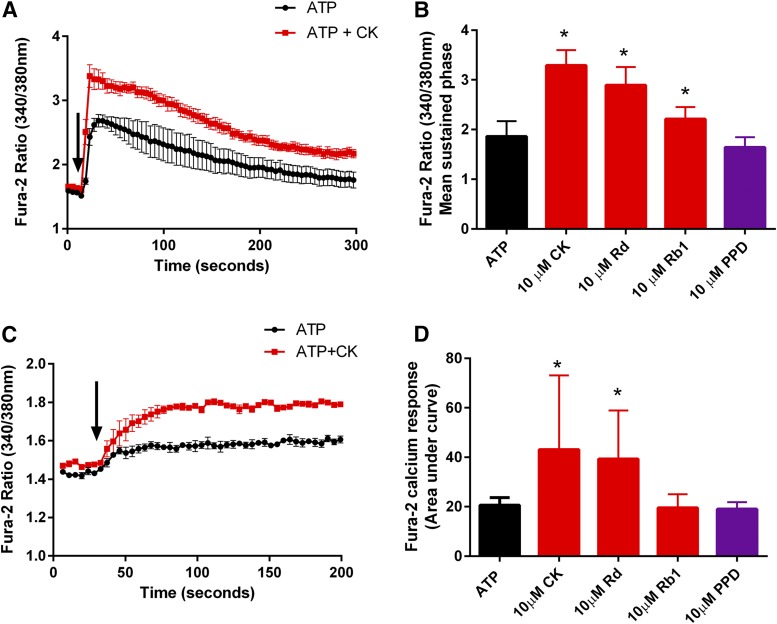
Ginsenosides enhance Ca2+ influx responses in cells expressing hP2X4. Intracellular Ca2+ responses were measured in (A) Fura-2 acetoxymethyl ester–loaded HEK-hP2X4 cells or (C) Fura-2 acetoxymethyl ester–loaded 1321N1-hP2X4 cells. Baseline values were recorded for 15–20 seconds, and then ATP was automatically injected at 30 seconds (arrow indicates agonist addition). Representative ATP responses are shown in black; ATP plus CK (10 μM) are shown in red. Error bars are S.D. (B) Ca2+ responses in HEK-hP2X4 were calculated as average Fura-2 ratio over the final 150 seconds. CK and Rd (10 µM) significantly increase hP2X4-mediated Ca2+ influx. *P < 0.05, one-way ANOVA with Dunnett’s multiple comparison post hoc test. (D) Ca2+ responses in 1321N1-hP2X4 cells were measured as area under the curve of zero baseline; error bars are S.D.; data are from four independent experiments.